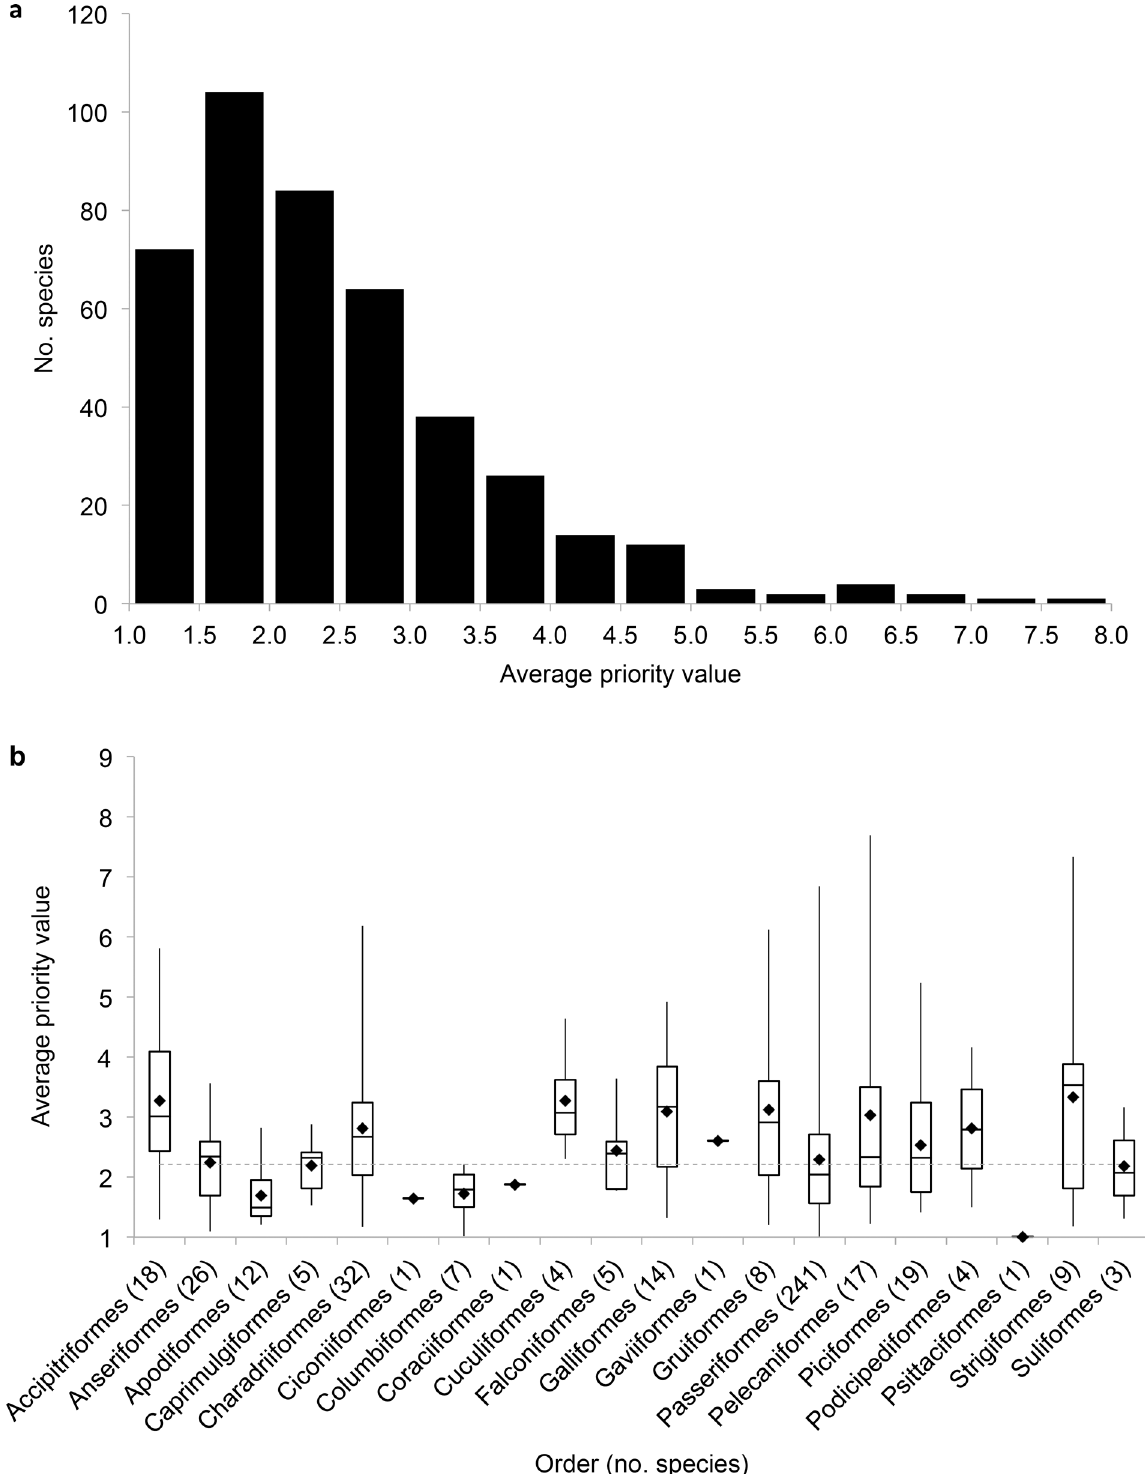
Fig 4. Overall priority results. The distribution of average overall priority score (a) across avian species and (b) within avian orders for 428 species that occur in the conterminous US. Higher values indicate higher priority and greater potential risk from wind facilities.